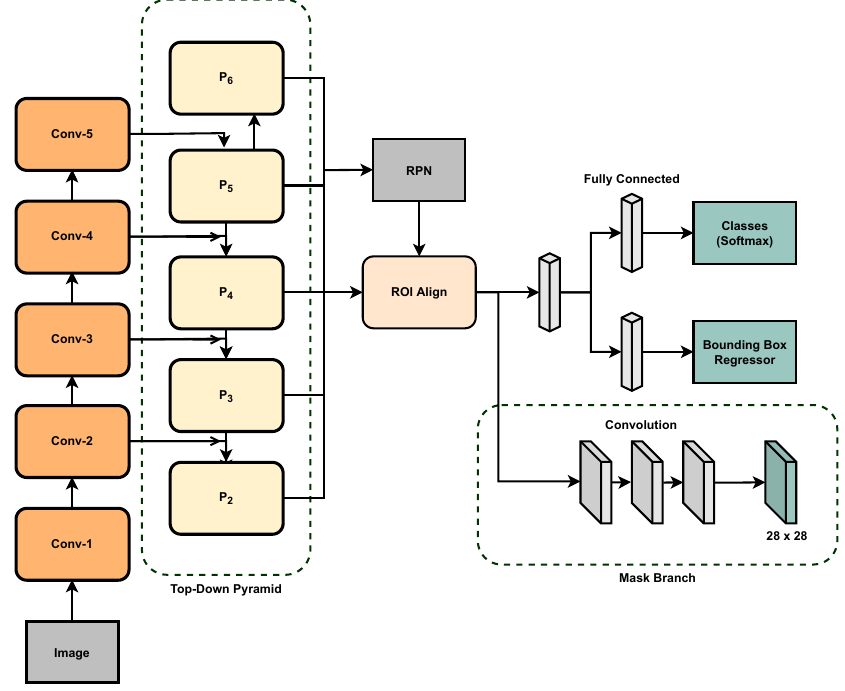
Figure 3. ResNet and Feature Pyramid Network (FPN)-based disease detection